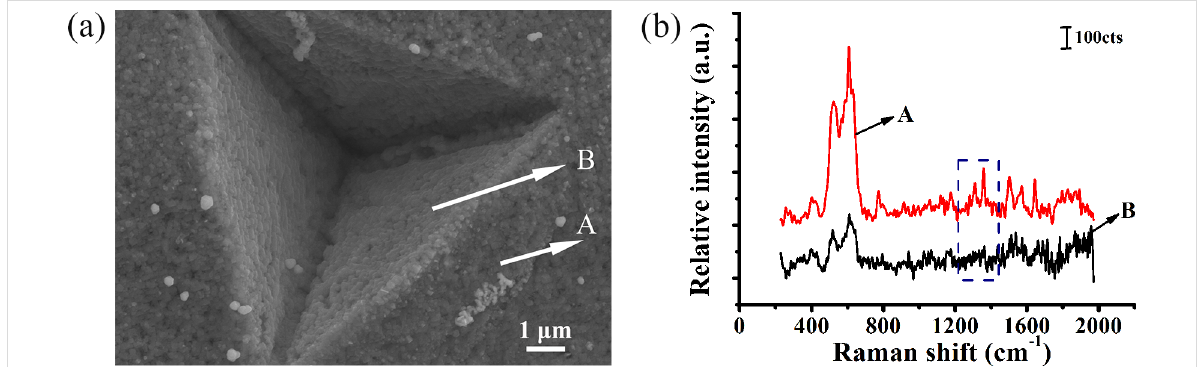
Figure 5: (a) SEM image of a single Ag/Cu pyramidal structure on the substrate with a feed of f x = 10 μ m, f y = 10 μ m. (b) Raman spectrum of R6G molecules at 10 − 8 mol/L on a single Ag/Cu substrate, where A and B represent the pile-ups and internal area of the cavity, respectively.